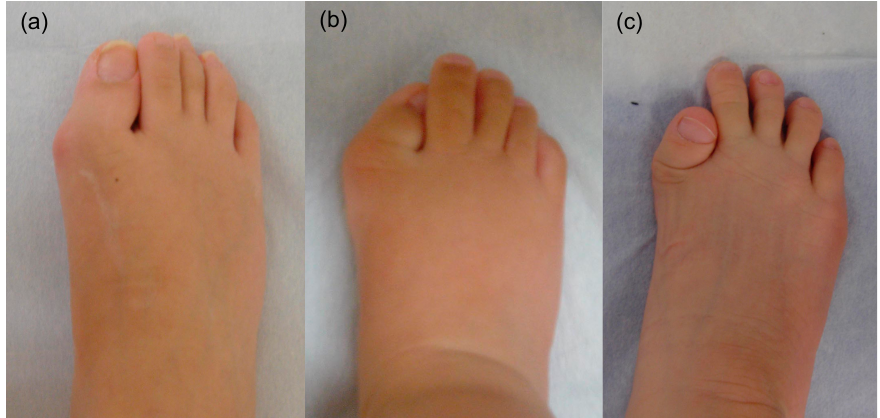
Figure 3. Gross appearance of the right foot in FOP patients from 18-year-old female ( a ), 10-month-old male ( b ), and 7-year-old male ( c ). The degree of hallux valgus and shortening of the great toes are variable.